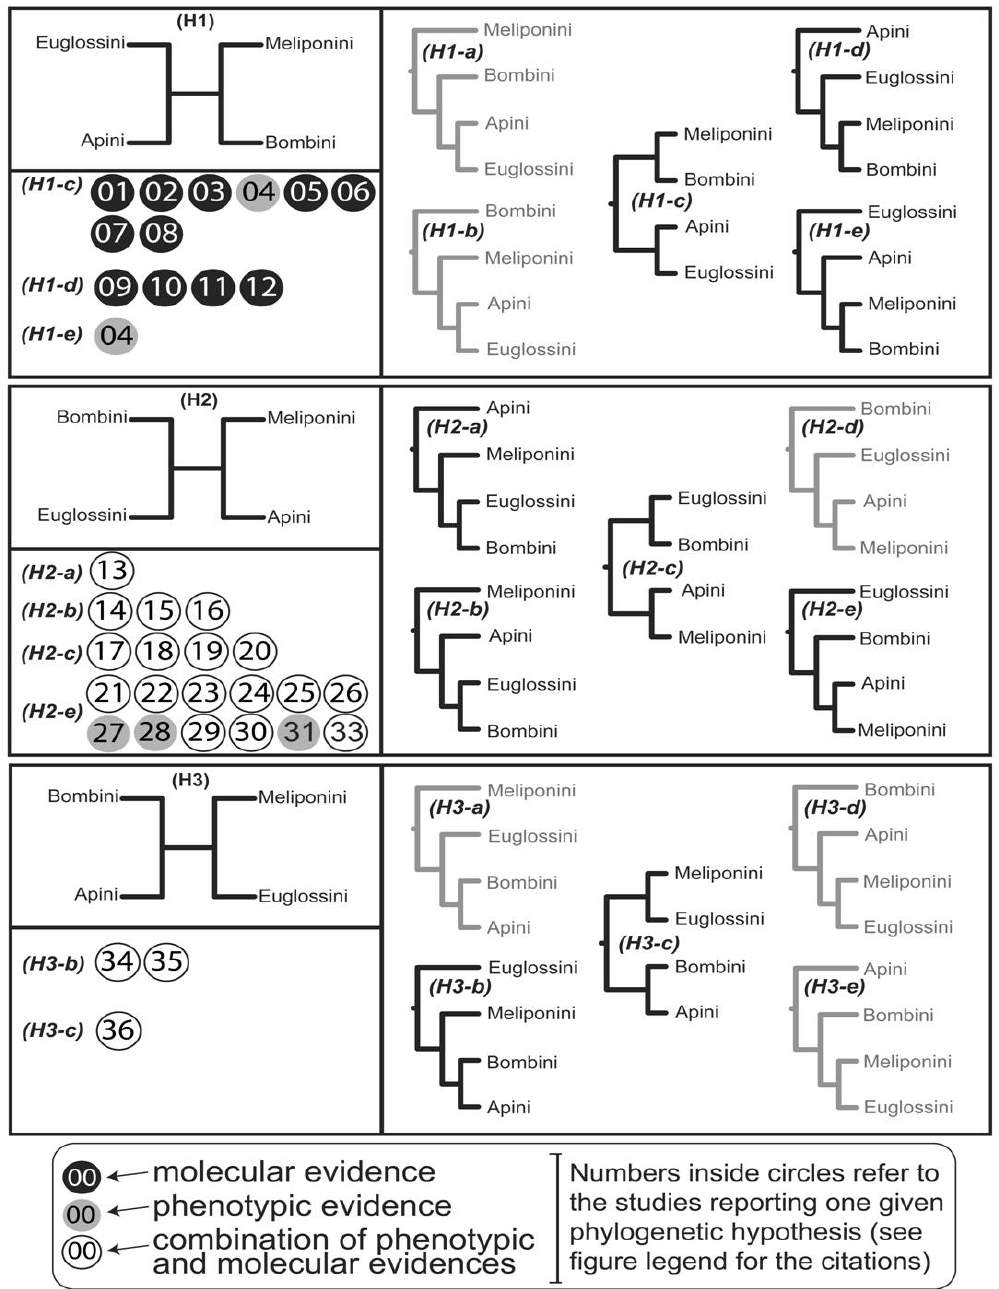
Fig 2. The corbiculate bee clade comprises four monophyletic groups: Apini, Bombini, Euglossini, and Meliponini. There are only three possible unrooted tree topologies that enable the representation of alternative scenarios for these four taxa, which are illustrated by the diagrams on the left (H1-H3). On the right column, the five possible rooted topologies are given to the corresponding three diagrams. Published hypotheses supporting each of the rooted tree topologies are given inside circles and can be tracked by the following reference numbering system: <01> Cameron (1991); <02> Koulianos et al. (1999); <03> Schultz et al. (1999); <04> Cameron & Mardulyn (2001); <05> Kawakita et al. (2008); <06> Cardinal et al. (2010); <07> Cardinal & Danforth (2011); <08> Cardinal & Danforth (2013); <09> Sheppard & McPheron (1991); <10> Cameron (1993); <11> Koulianos et al. (1999); <12> Mardulyn & Cameron (1999); <13> Kerr (1987); <14> Winston & Michener (1977); <15> Kimsey (1984); <16 >Sakagami & Maeta (1984); <17> Michener (1974); <18> Michener (1990); <19> Schultz et al. (1999); <20> Serrão (2001); <21> Michener (1944); <22> Maa (1953); <23> Michener (1990); <24> Prentice (1991); <25> Roig-Alsina & Michener (1993); <26> Chavarría & Carpenter (1994); <27> Schultz et al. (1999); <28> Ascher et al. (2001); <29> Engel (2001a, b); <30> Noll (2002); <31> Cardinal & Packer (2007); <32> Payne (2013); <33> Canevazzi & Noll (2014); <34> Plant & Paulus (1987); <35> Peixoto & Serrão (2001); <36> Pereira-Martins & Kerr (1991). Placement of outgroup taxa (i.e., non-corbiculate bees) was ignored when accounting for the support of published hypotheses in relation to the 15 possible rooted cladograms. All unrooted tree topologies were favored by at least one published study as noticeable by references listed in the figure; and nine out of the fifteen possible rooted tree topologies were favored by at least one study (black trees on the right of the figure). Three points are worth highlighting when evaluating the support given by the various types of data and/or authors about these alternative phylogenetic scenarios: (1) there is a clear prevalence of molecular data supporting hypotheses shown in H1; (2) there is a clear prevalence of phenotypic genotypic data supporting hypotheses shown in H2; (3) scenarios shown in H3 have received lower support by empirical data than